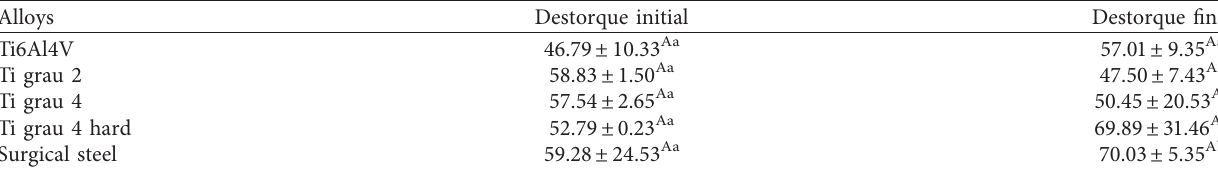
Table 1: Means and standard deviation of torque maintenance (%) as a function of alloys used, independent of the